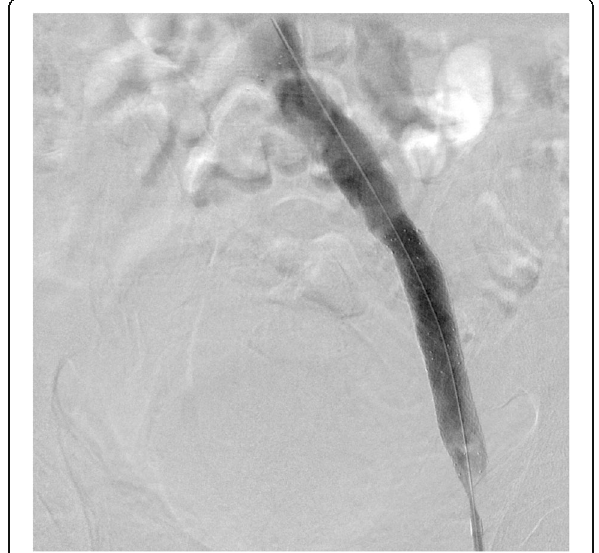
Fig. 3 Post-stenting venography. Brisk flow is demonstrated through the stented occlusion. Drainage through the sapheno-saphenous collaterals is no longer